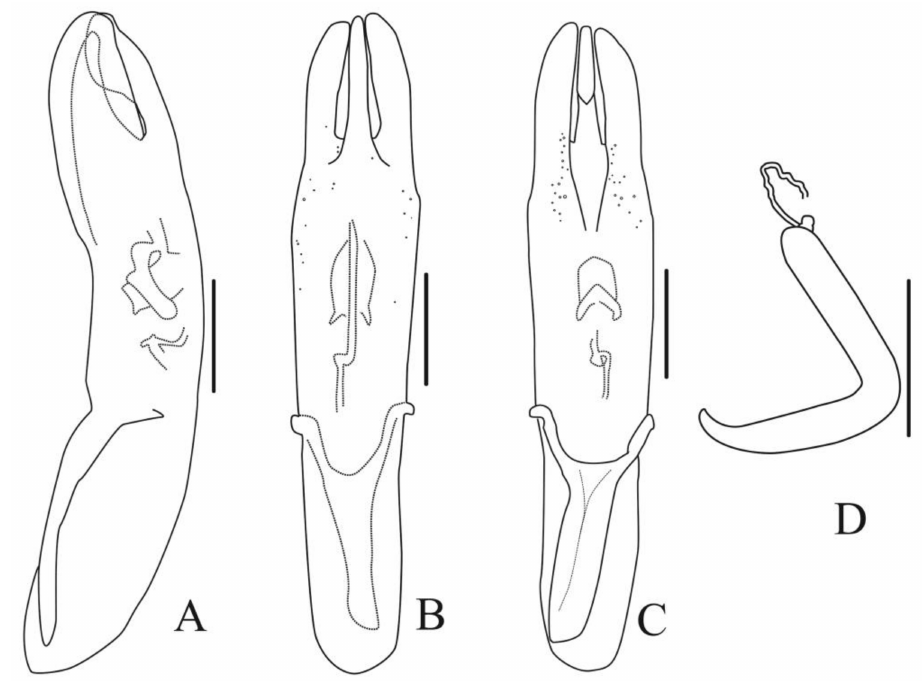
Figure 7. Cryptocephalus ( Burlinius ) tomurensis Duan & Zhou, sp. nov.: ( A ) lateral view of aedeagus; ( B ) dorsal view of aedeagus; ( C ) ventral view of aedeagus; ( D ) spermatheca. (Scale bars: 0.2 mm.) Type of locality is China, Xinjiang, Aksu Prefecture, Wensu County, Tomur